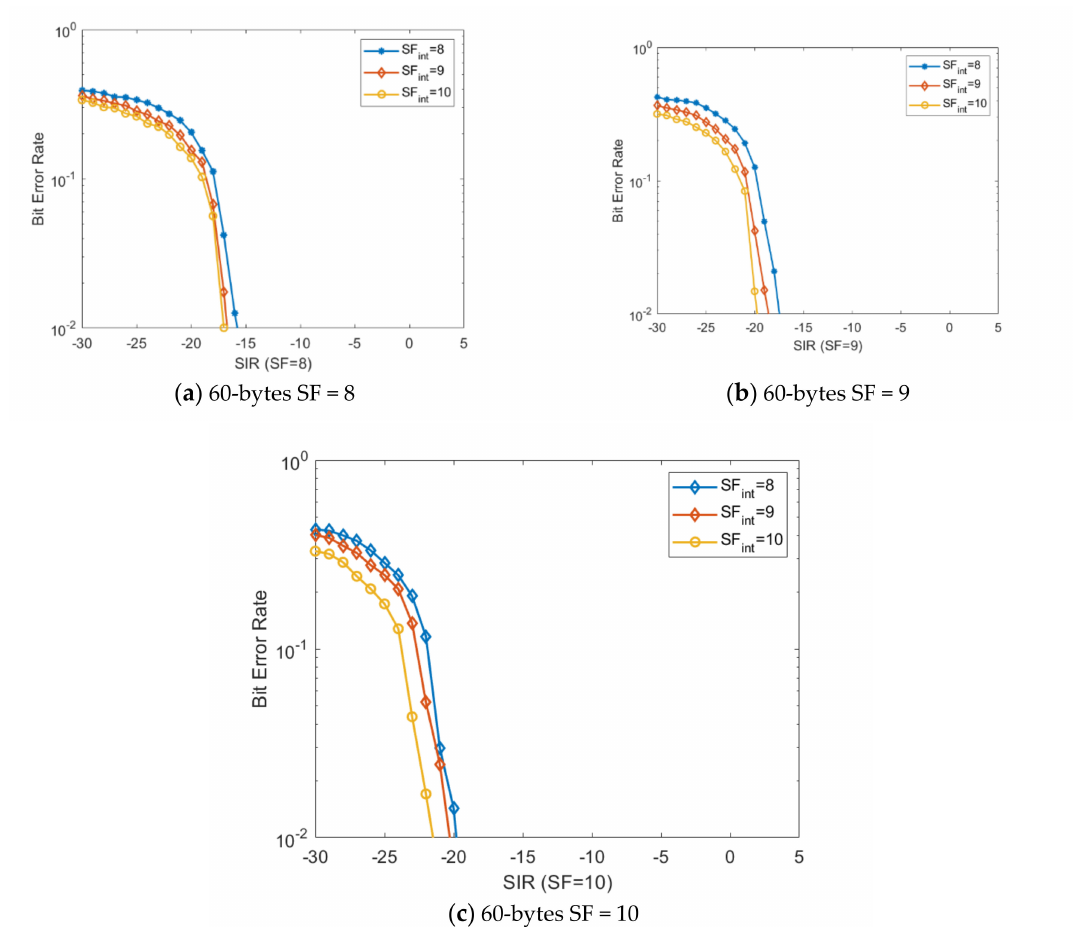
Figure 5. The analysis of performance for SF8 when using a packet payload of 60 bytes. The SF is varied from SF8 to SF10, and the analyzed bandwidth is 500